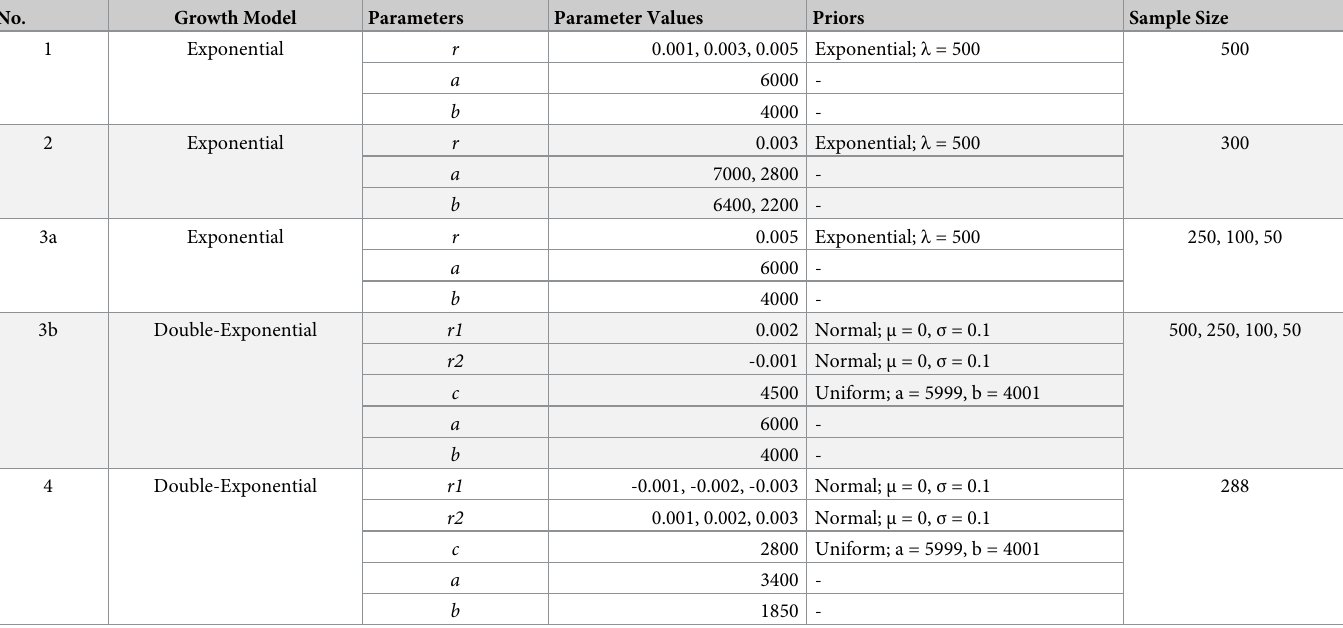
Table 1. Parameter settings and priors for experiments